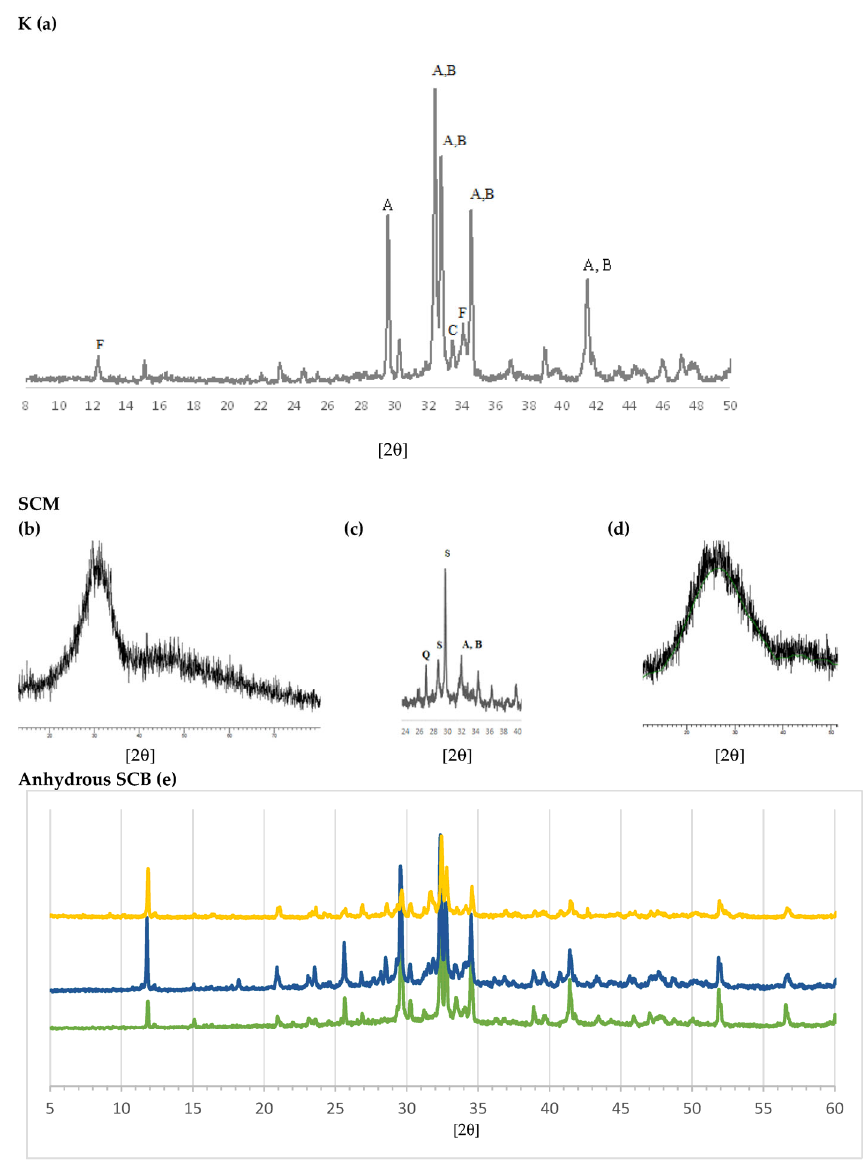
Figure 4. Diffractograms: ( a ) clinker (K), where A is C3S, B is C2S, C is C3A and F is C4AF. SCM: ( b ) blast furnace slag (S). ( c ) SCM2, where A is C3S, B is C2S, Q is quartz and S is silicate. ( d ) Fibreglass (FG). ( e ) Anhydrous SCB: green: CEM III/A; dark blue: SCB1; yellow: SCB2.